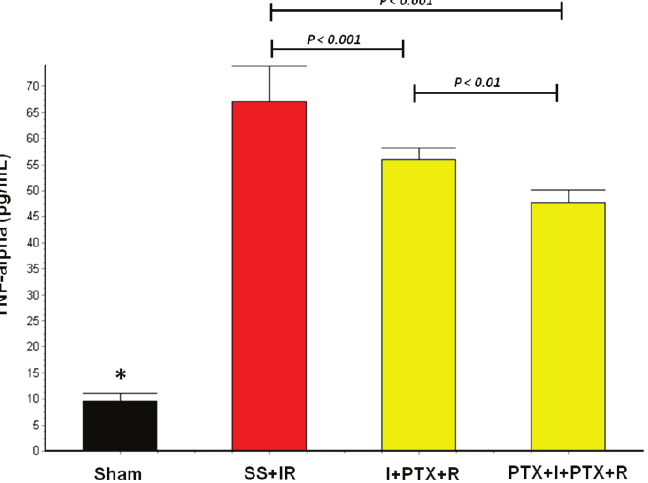
(47.57 ± 2.64 pg/mL).